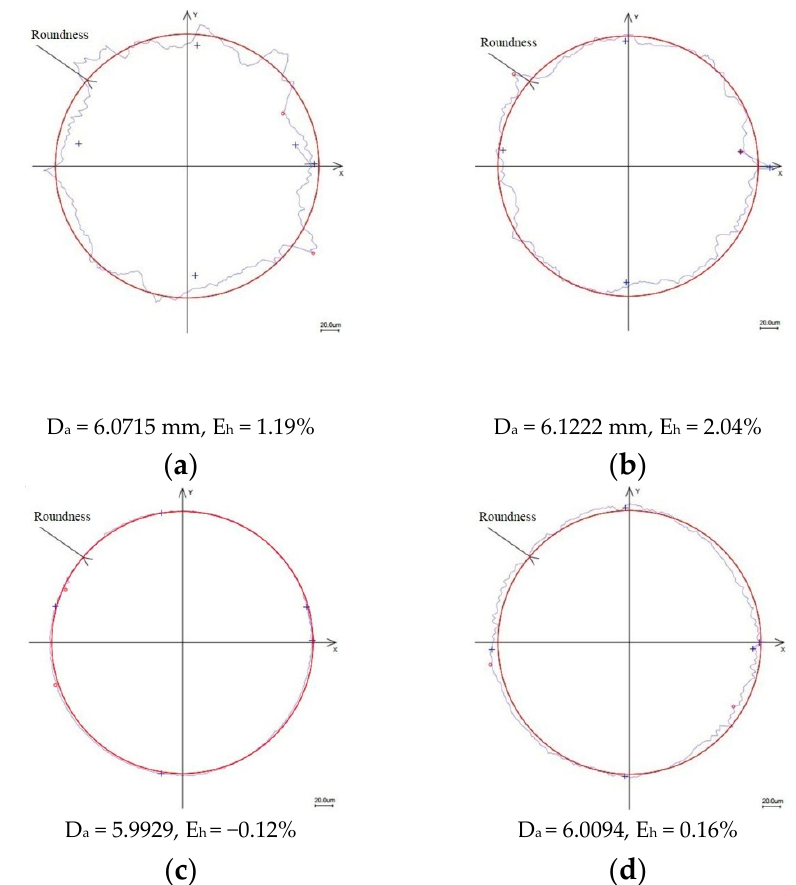
Figure 9. Comparison of circumferential profile and diameter error (E h ) of 15th hole drilled at feed rate of 400 mm/min with varying cutting speeds: ( a ) 3000 rpm; ( b ) 6000 rpm; ( c ) 9000 rpm; ( d ) 12,000 rpm.